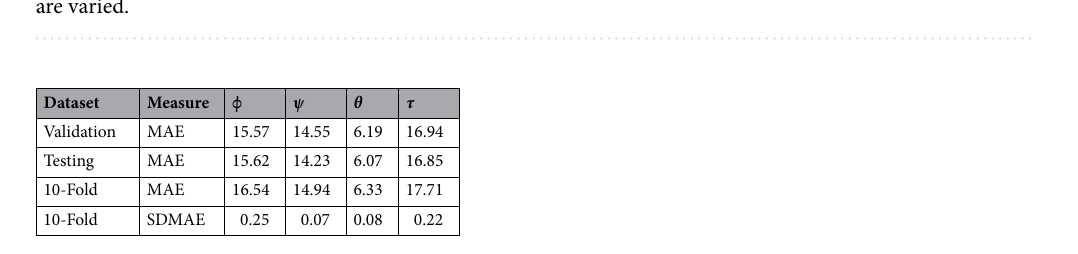
Results below are as we run all of the systems on our datasets Dataset Proteins